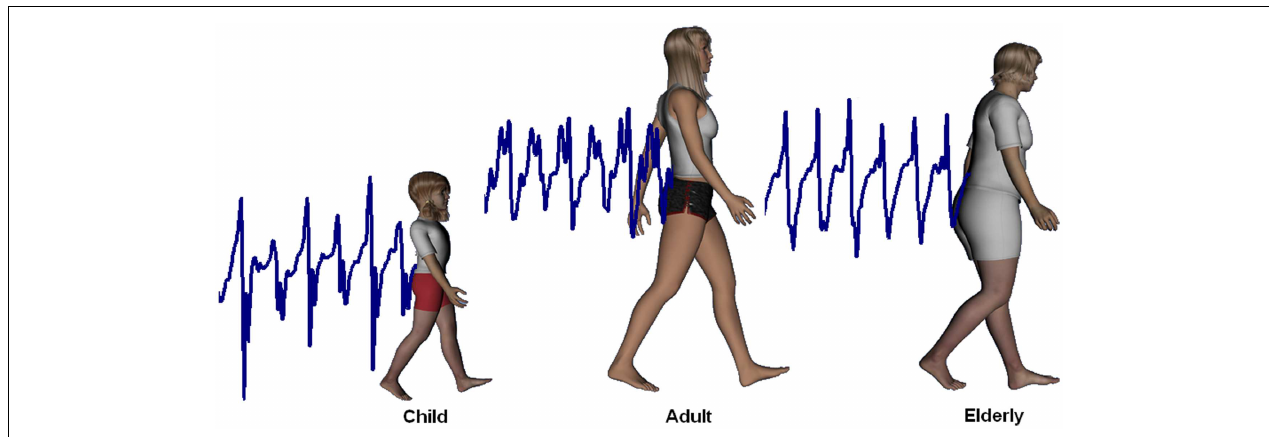
FIGURE 1 | Upper body accelerations . Upper body accelerations along the antero-posterior direction in a child (data obtained for a 2-year-old female), an adult (35years, female), and an elderly subject (69years,